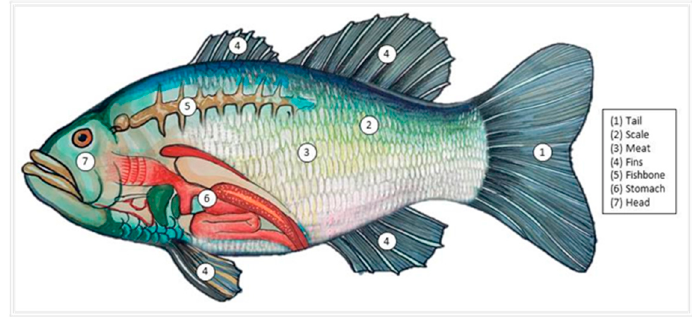
Table 2. Limit of detection (LOD) of Olympus Vanta XRF [35].